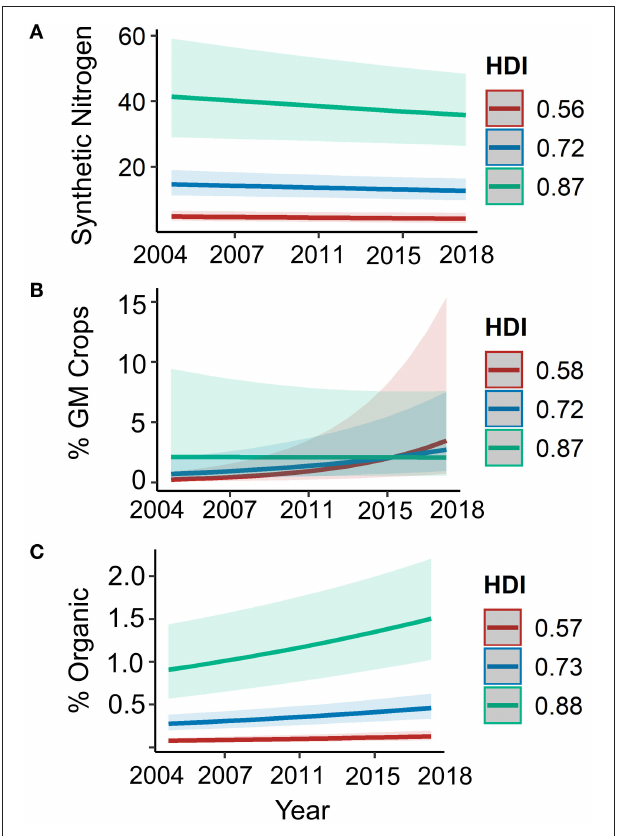
FIGURE 4 | The Human Development Index (HDI) predicts agricultural strategies used. Regressions from longitudinal generalized linear mixed-effects models predict (A) synthetic nitrogen inputs ([tons/1,000 ha]/100), (B) percentage of crops that are genetically modified (GM), and (C) percentage of agricultural production in organic over a 15-year period (2004–2018) at the country level against the HDI. HDI in the figure is divided at the mean value, as well as one standard deviation below and above the